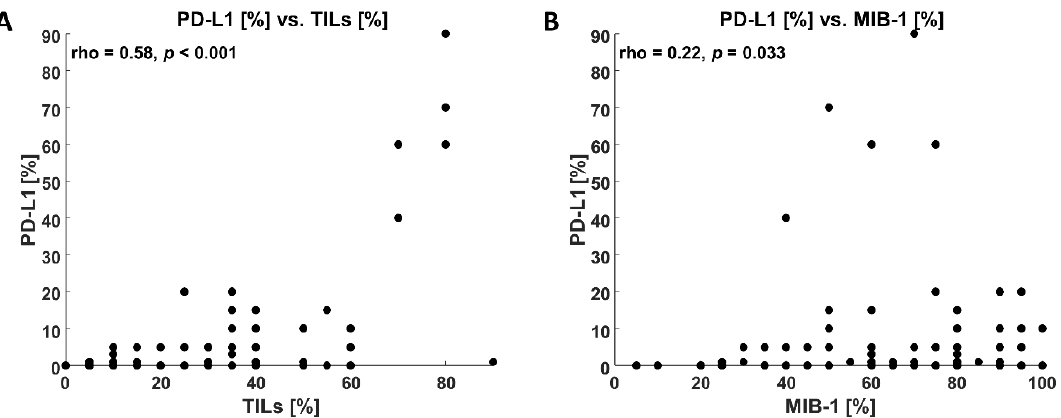
Figure 2. Correlations between PD-L1 and TILs (panel A ) and PD-L1 and MIB-1 (panel B ). Spearman correlation coefficient (rho) and p -value are located within the figure.